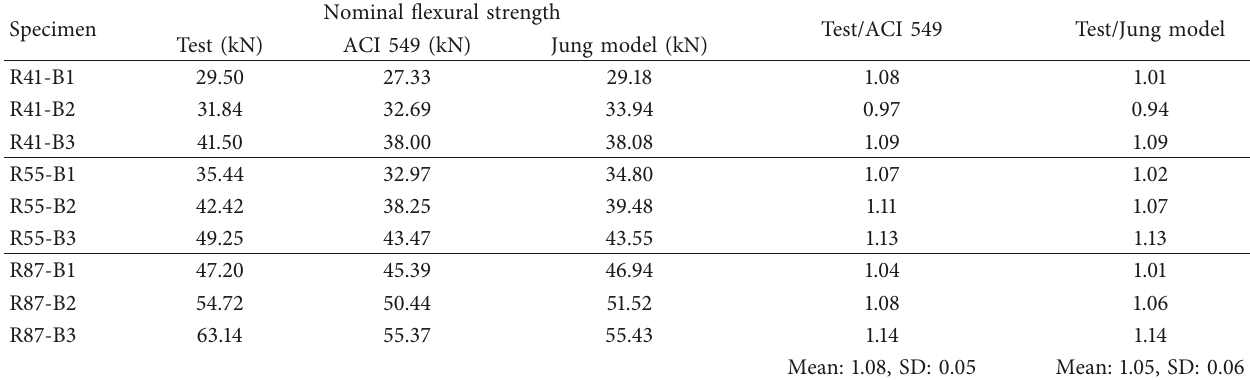
Table 7: Comparison of nominal flexural